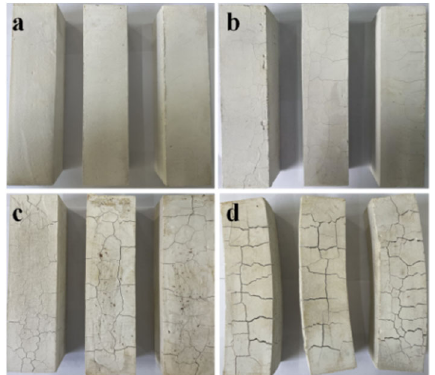
Figure 4. Macro morphology of the MOC samples after different dry–wet cycles: ( a ) without dry–wet cycles; ( b ) one time; ( c ) two times; ( d ) three times.